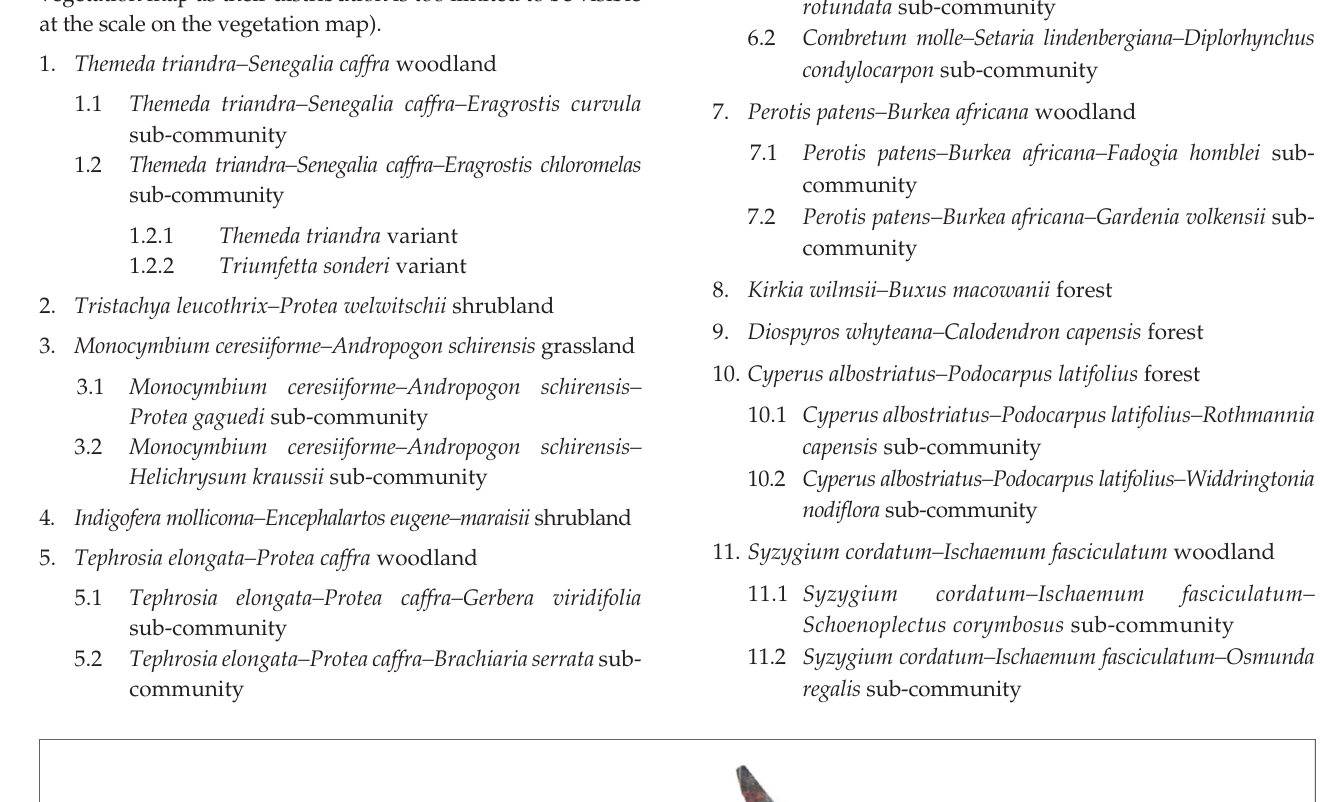
Legend Plant community 1. Themeda triandra-Senegalia caffra